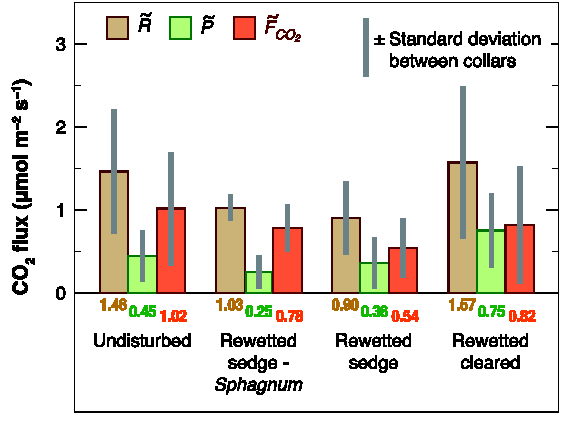
Figure 4. Calculated summertime net carbon dioxide (CO 2 ) flux from the ground and low- separated into soil growing vegetation ( respiration plus above-ground autotrophic 𝐹𝐹� 𝐶𝐶𝐶𝐶2 ) respiration of the vegetation in the collars ( ) and photosynthesis of the vegetation in the collars ( ) 𝑅𝑅� at all four sites for the period 26 Jun to 11 Aug 2014. 𝑃𝑃�